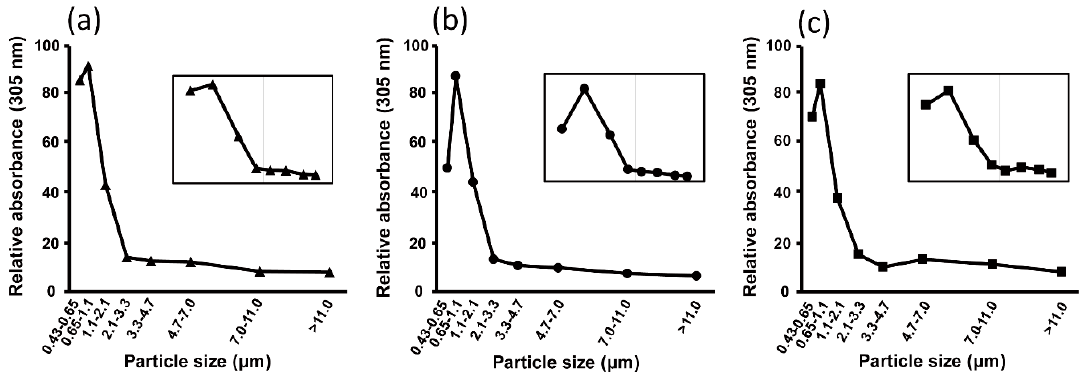
Figure 1. Ultraviolet ( UV) absorbance profile of size-segregated aerosols collected during different periods: ( a ) November, preheating period; ( b ) January, heating period; and ( c ) March, postheating period. The data points of the x-axis were determined by the midpoint of each range of particle sizes. The insets show the corresponding distributions with a log-scaled x-axis for particle size.